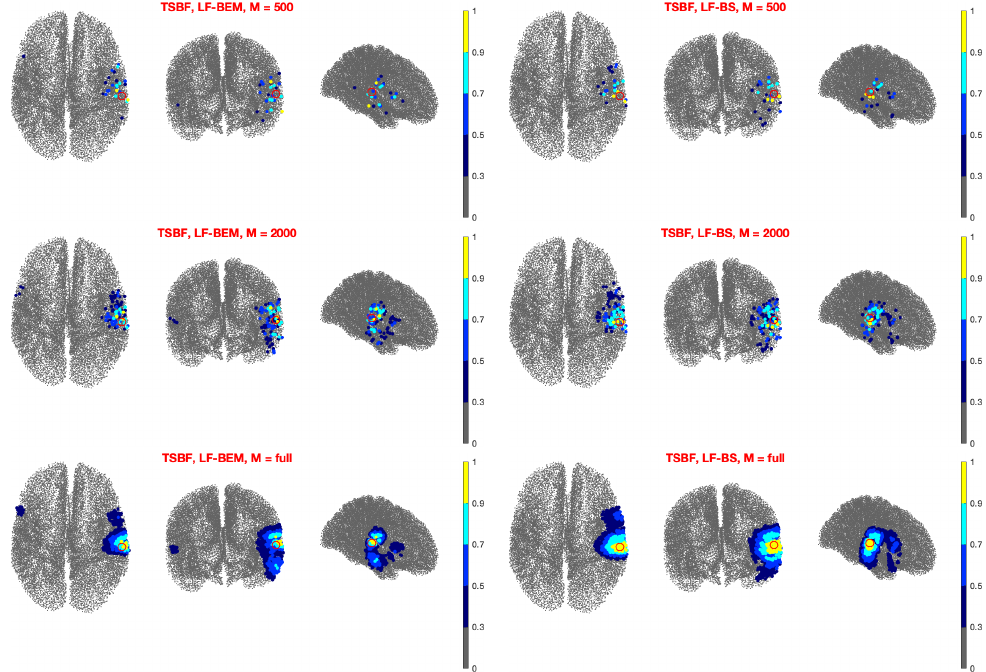
Figure 10. Left Auditory evoked field: The intensity of the estimated sources, averaged over N = 10 runs, at 90 ms obtained using TSBF with M = 500 random points (first row), M = 2000 (second row) and the full source space (third row) for LF-BEM (left column) and LF-BS (right column). The red circle represents the dipole fitted using MNE.